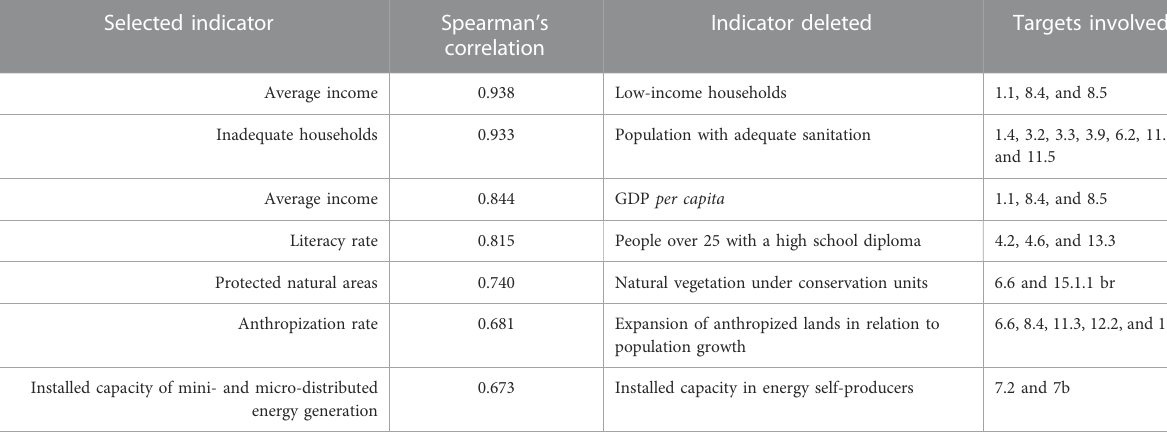
TABLE 2 Selection and exclusion of indicators according to redundancy